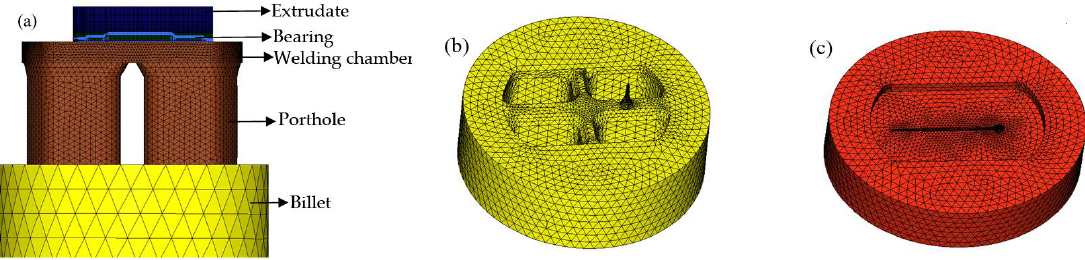
Figure 3. Mesh generation of ( a ) the flow domains, ( b ) upper die, and ( c ) lower die in FE model.